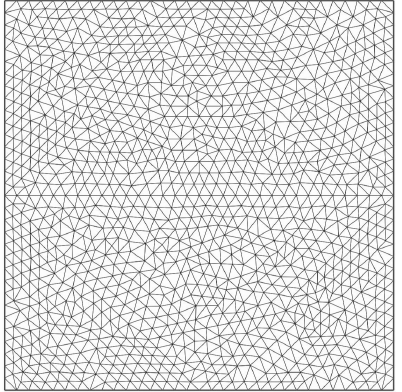
Figure 3. A sample mesh with N = 32 for Example 1.